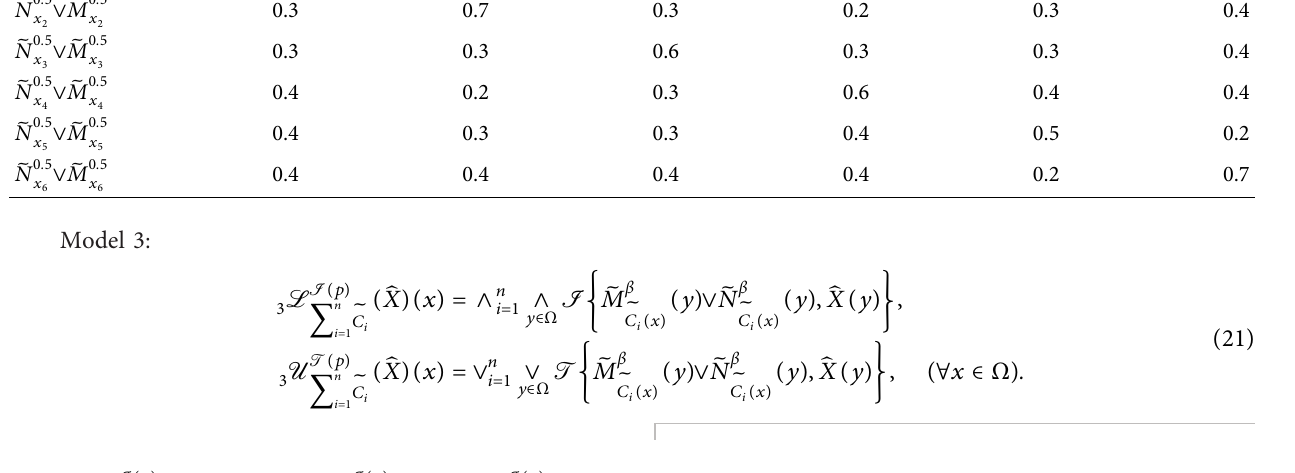
Table 9: Table for 􏽥 N β